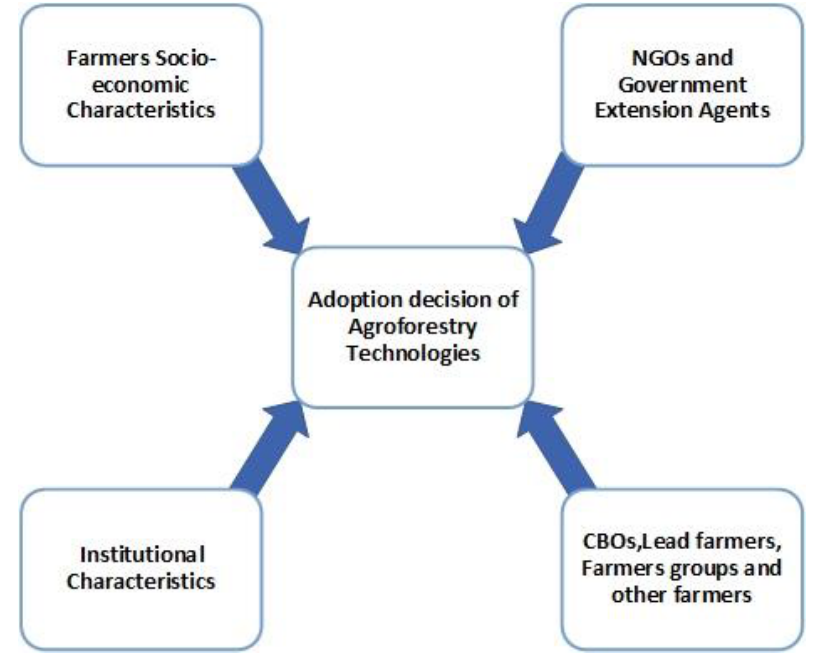
Figure 2. Factors affecting a farmer’s adoption decision.